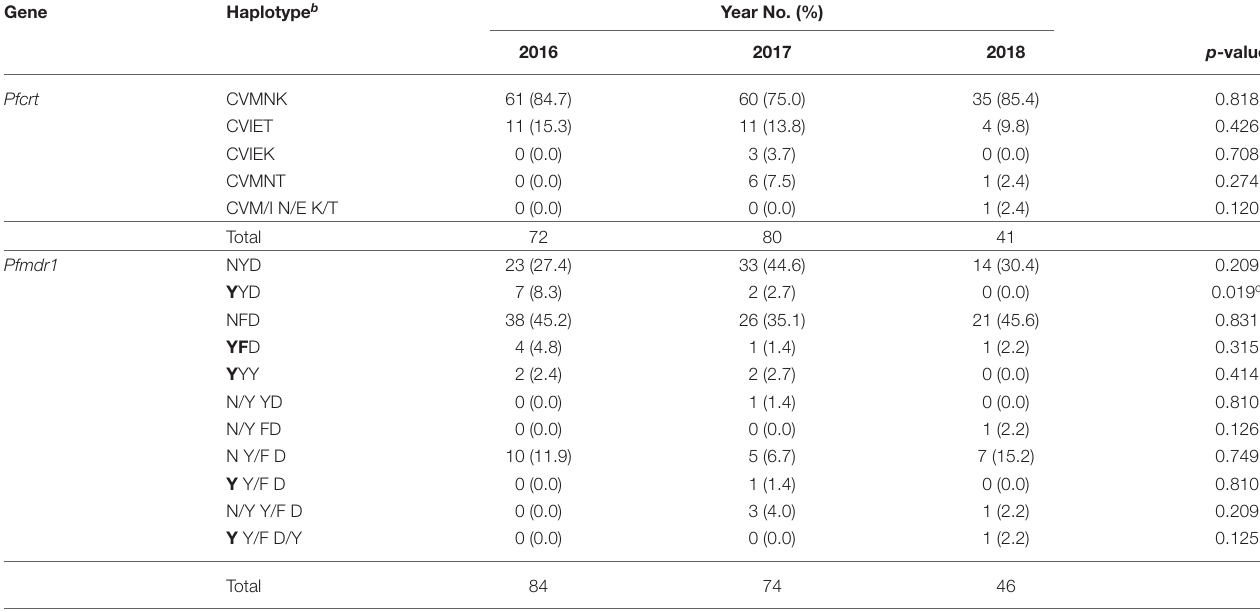
TABLE 5 | Haplotypes of Pfcrt and Pfmdr1 from studied isolates a . Gene